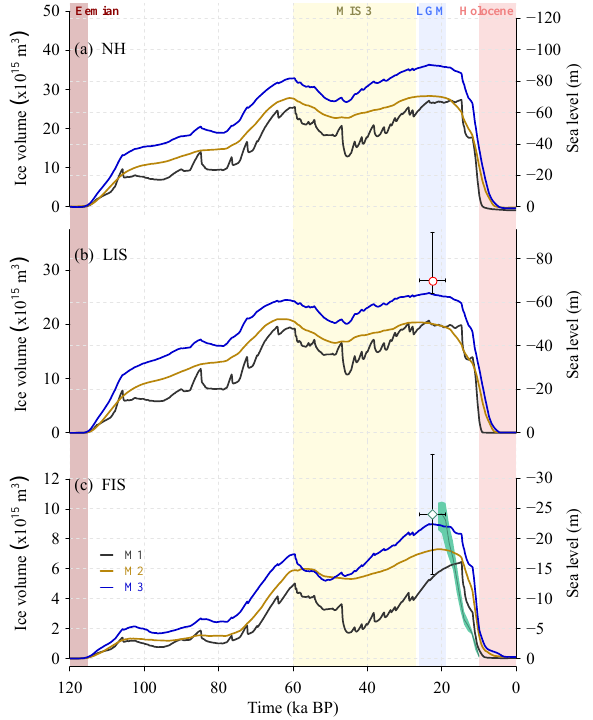
Figure 6. Temporal evolution of ice volume (m 3 ) relative to initial conditions simulated in M1 (gray), M2 (gold) and M3 (blue) for (a) the NH domain; (b) the LIS and (c) the FIS. Ice-volume vari- ations have also been expressed in sea-level equivalent units (m). Estimates of the SLE change at the LGM relative to the present for the LIS (red dot; Tarasov et al., 2012) and for the FIS (light green diamond; Hughes et al., 2016) are indicated for comparison in panels (b) and (c) , respectively. Vertical error bars represent the range of SLE estimates at the LGM for the LIS and the FIS (Den- ton and Hughes, 1981; Clark and Mix, 2002; Clark and Tarasov, 2014). Horizontal error bars represent the approximate timing of the LGM (ca. 26.5–19kaBP; Clark et al., 2009). The temporal evo- lution of ice volume (m 3 ) for the Eurasian ice sheet from the most- credible DATED-1 reconstruction (light green solid line; Hughes et al., 2016) together with its minimum and maximum lines (shaded area) have also been included in panel (c) . Vertical colored bars in- dicate key periods of the past 120kyr